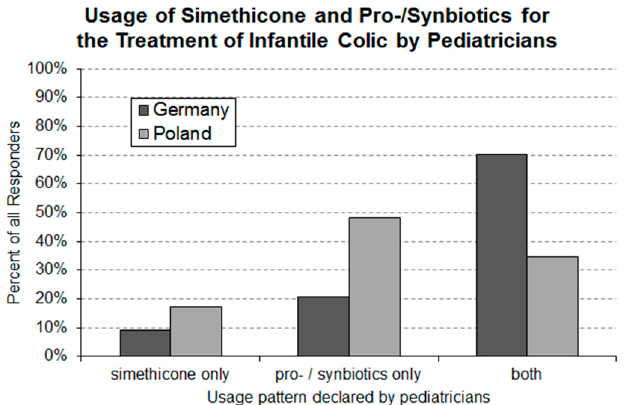
Figure 7. Usage pattern of pro-/synbiotics and simethicone by German ( n = 160) and Polish ( n = 133) pediatricians for the treatment of infantile colic. Statistical analysis using the standard Asymptotic